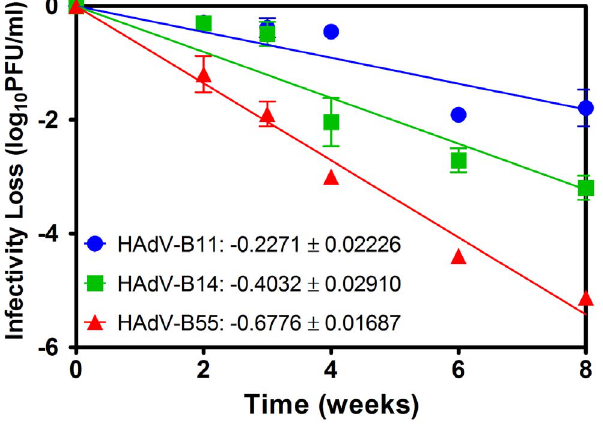
Figure 5. The effect of heat treatment on the infectivity of HAdV-B55, HAdV-B14 and HAdV-B11. The viruses were incubated for 2, 3, 4, 6 or 8 weeks at 37 u C. Viral titers in heat-treated virus samples were determined by plaque assays on A549 cells. Each value represents the mean 6 standard deviation of two separate experiments.